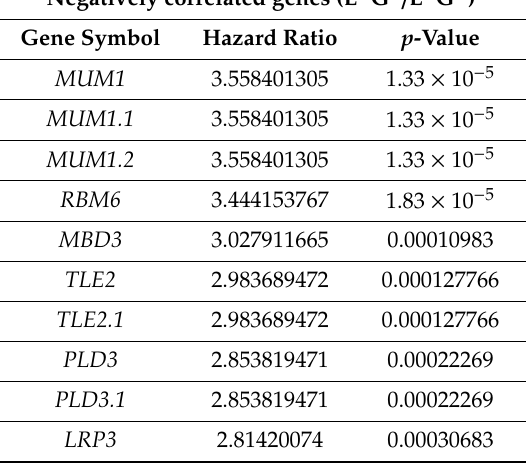
Table 5. Shows Cox proportion hazard ratio with p -value of top negatively correlated genes having potential of prognostic biomarkers, genes sorted based on p